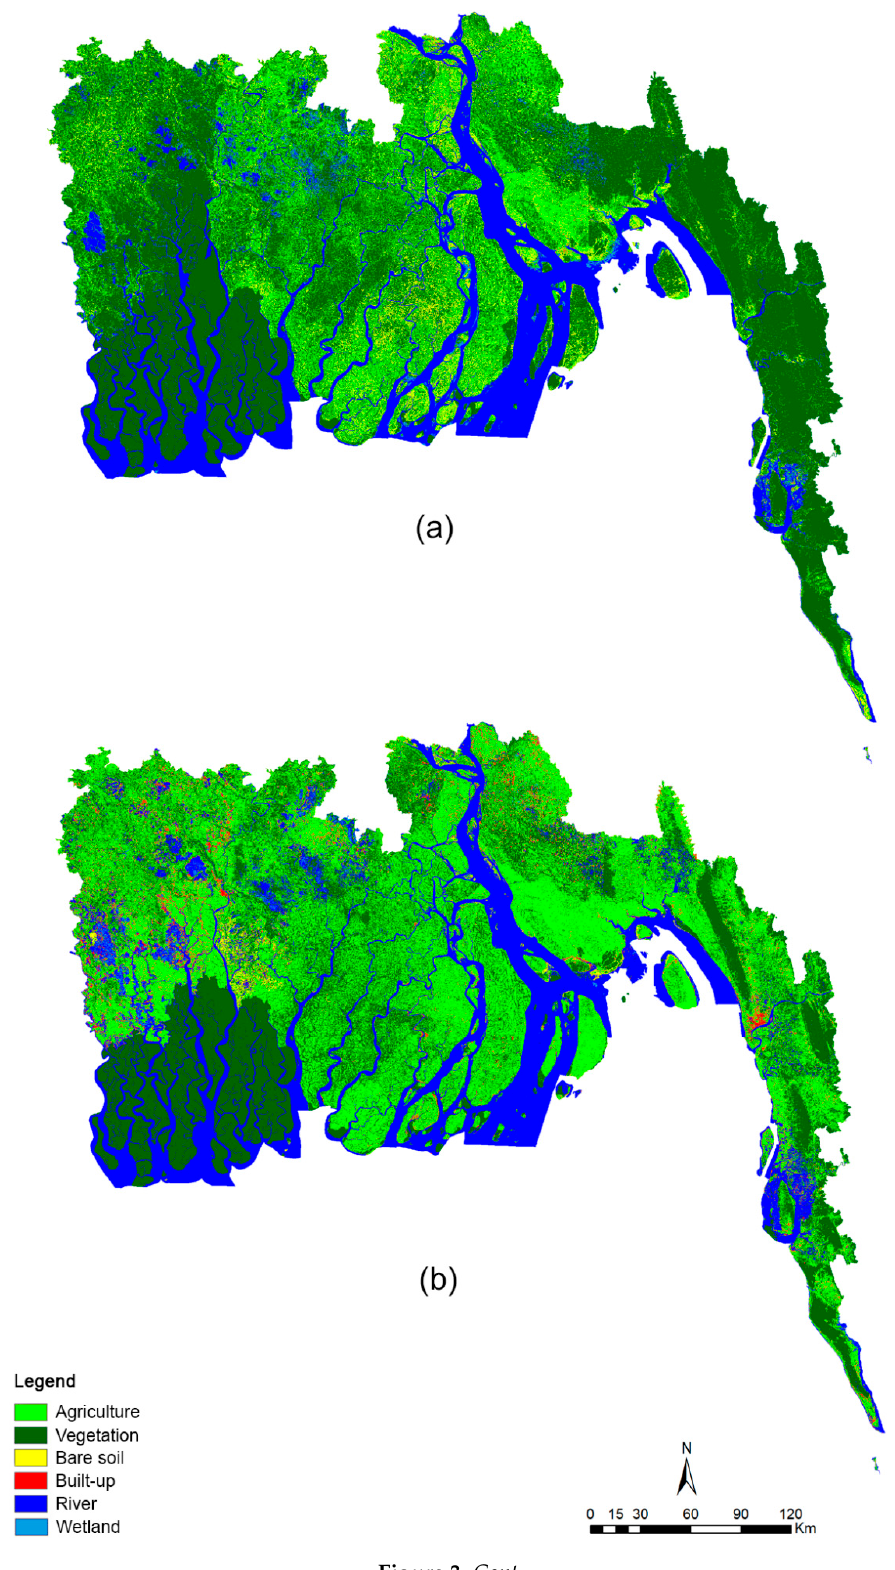
Figure 3. Figure 3. Classified land cover maps of the coastal area of Bangladesh: (a) 1990 and (b) 1995.